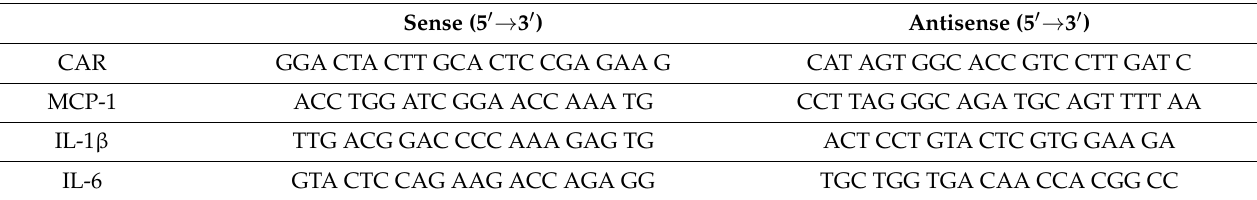
Table 1. Real-time PCR primer